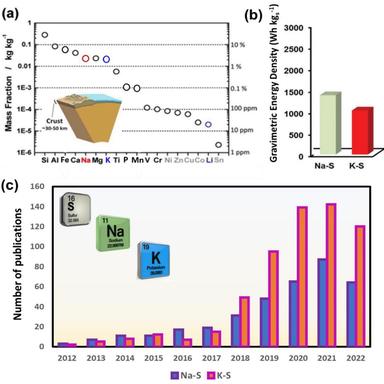
Comparison of a) geographical abundance of Na and K. Reprinted (adapted) with permission from Ref. . Copyright 2014 American Chemical Society. and b) energy density. Reprinted (adapted) with permission from Ref. . Copyright 2020 John Wiley and Sons. c) recent trend of publications in NaeS and KeS batteries (Source: Scopus, retrieved from the search of "room-temperature sodium-sulfur batteries" and "potassium sulfur batteries," on October 7, 2022).